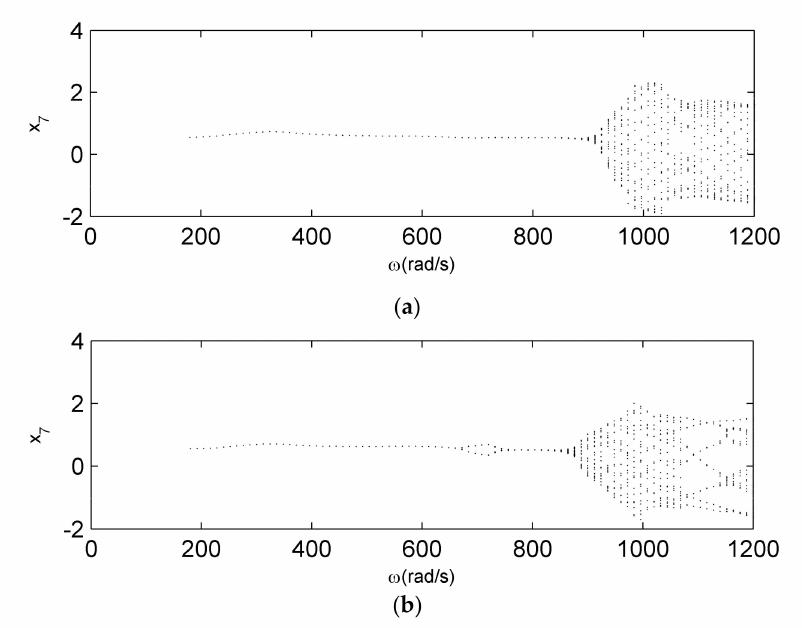
Figure 14. Bifurcation diagrams for coupled fault system. ( a ) a = 0.6 R . ( b ) a = R .